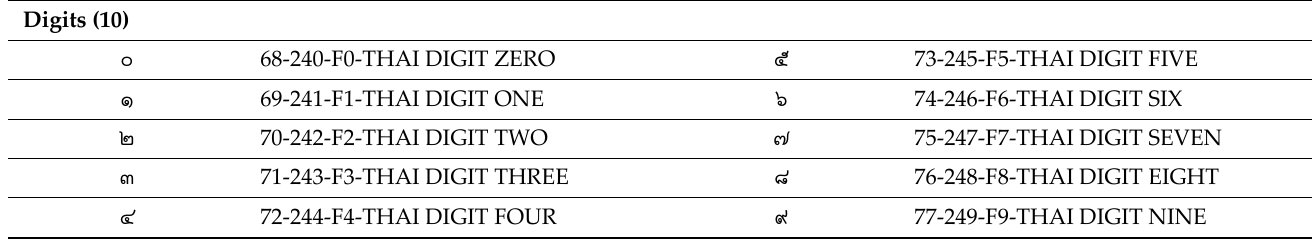
Table A2. Thai digits classes considered for the dataset constructions.